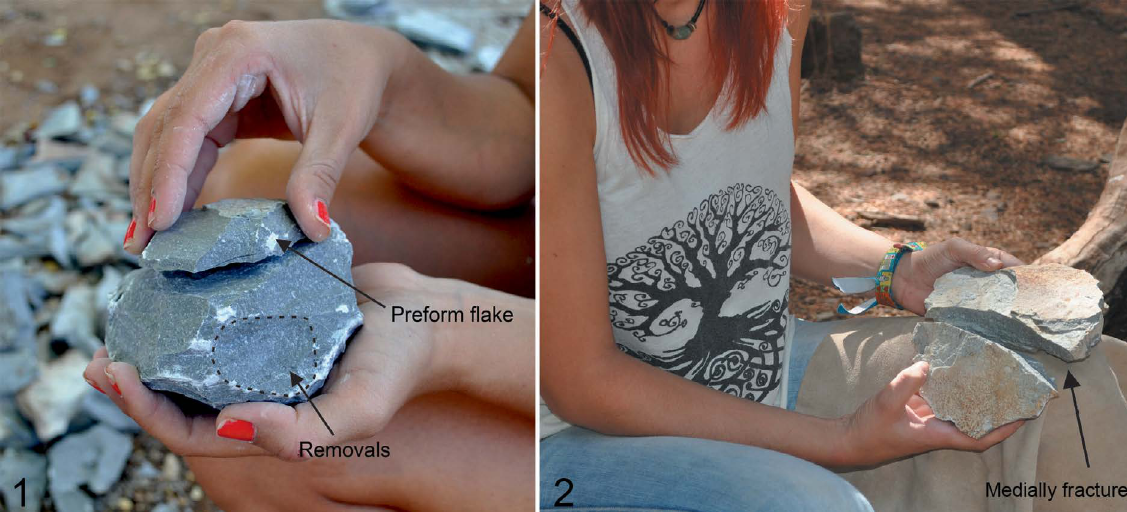
Figure 5. Experimental knapping of dolomitic marble. 1. Technical stigmata and 2. Example of knapping